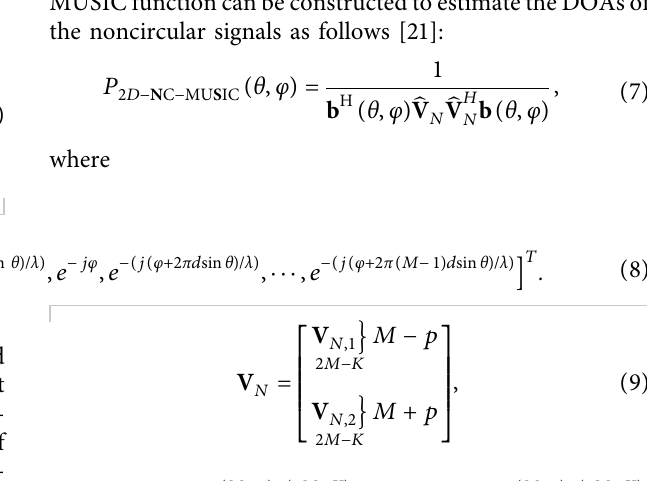
Figure 1: Array signal